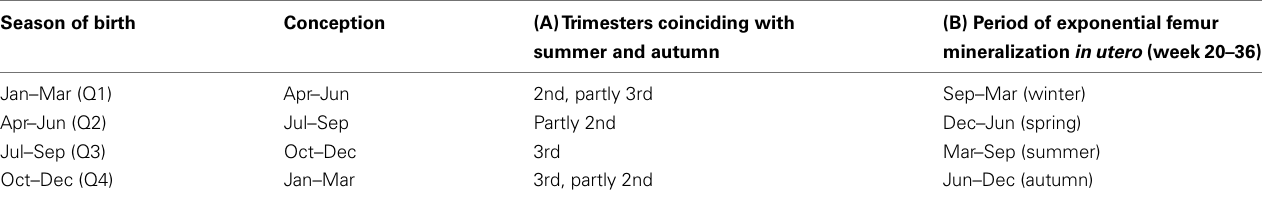
Table 4 | Relationship between season of birth and the season coinciding with the three trimesters (A) and with the period of exponential mineralization of the femur in utero (B).